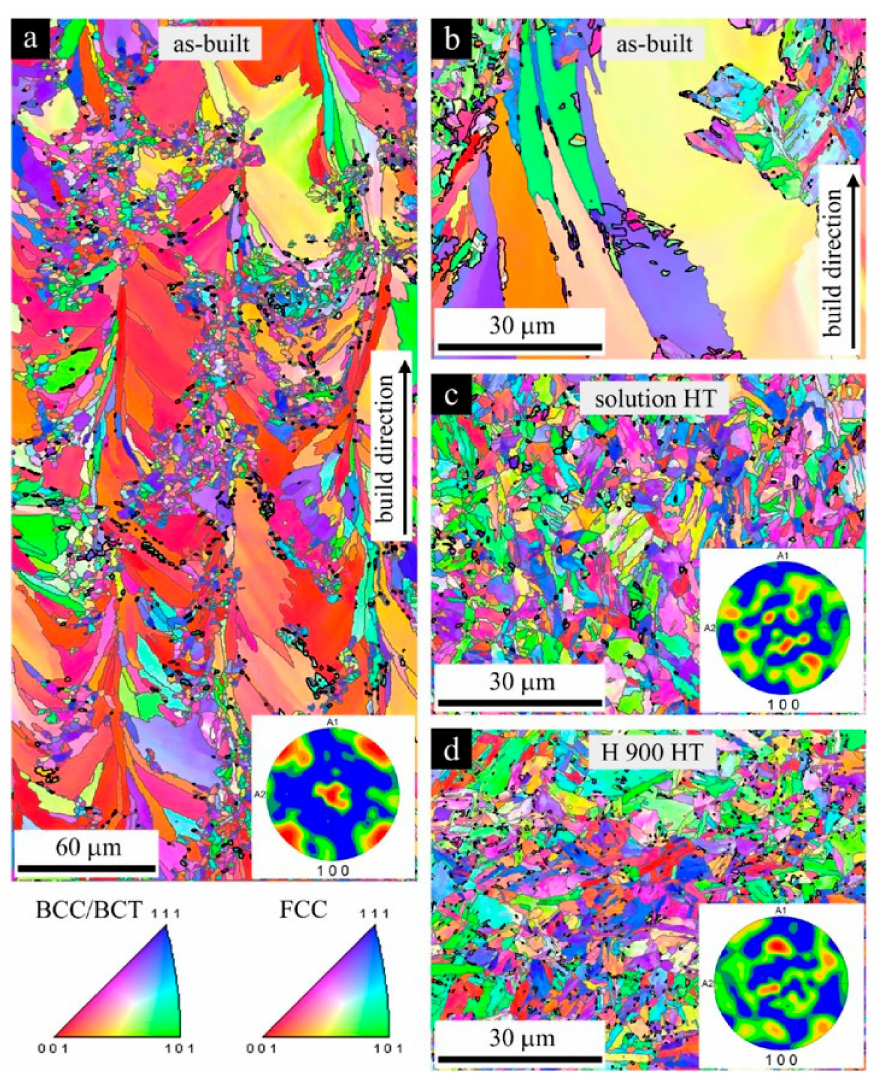
Figure 4. EBSD orientation maps: ( a , b ) as-built sample; ( c ) solution heat-treated (HT) sample; ( d ) H900 sample [123], 17–4